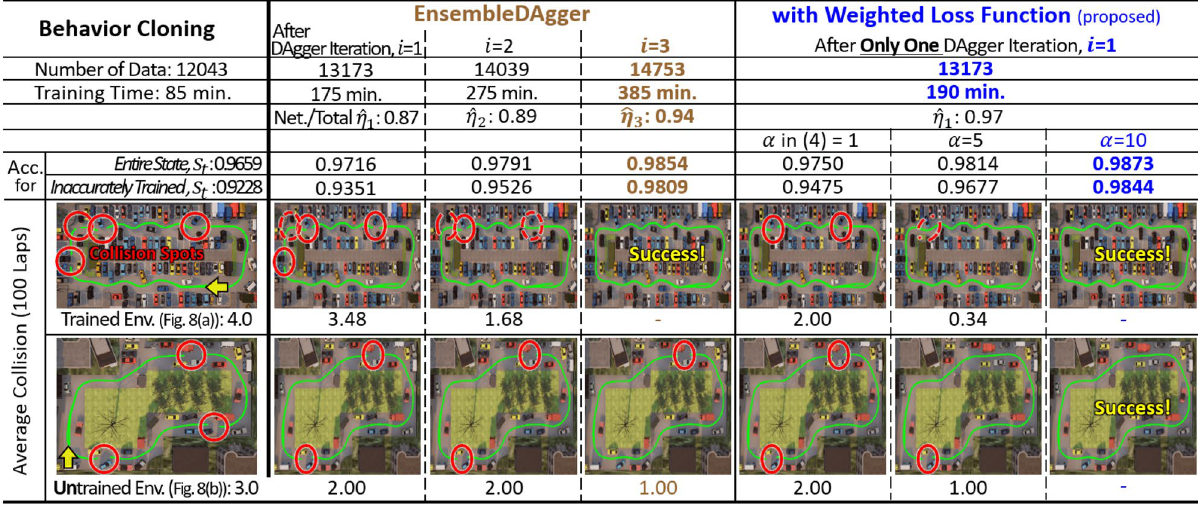
Ensemble -DAgger With